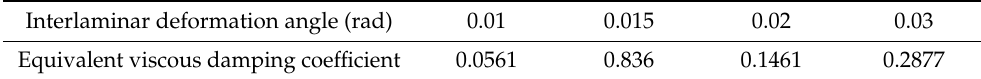
Table 4. Equivalent viscous damping coefficient.